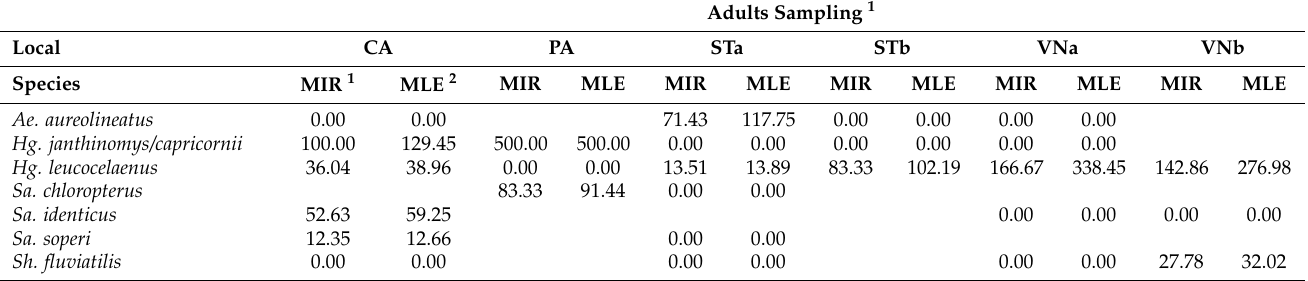
Table 3. Rates of YFV natural infection in mosquitoes collected in adult sampling 1 at Cariacica (CA), Pancas (PA), Venda Nova do Imigrante (VNa and VNb), and Santa Teresa (STa and STb), Esp í rito Santo, 2017. Adults Sampling